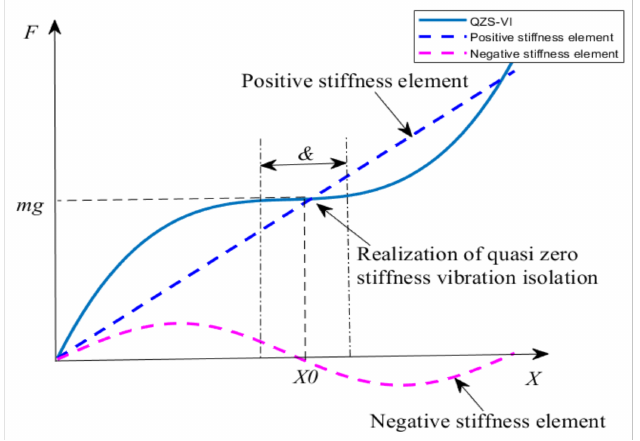
Figure 2. Schematic diagram of QZS.